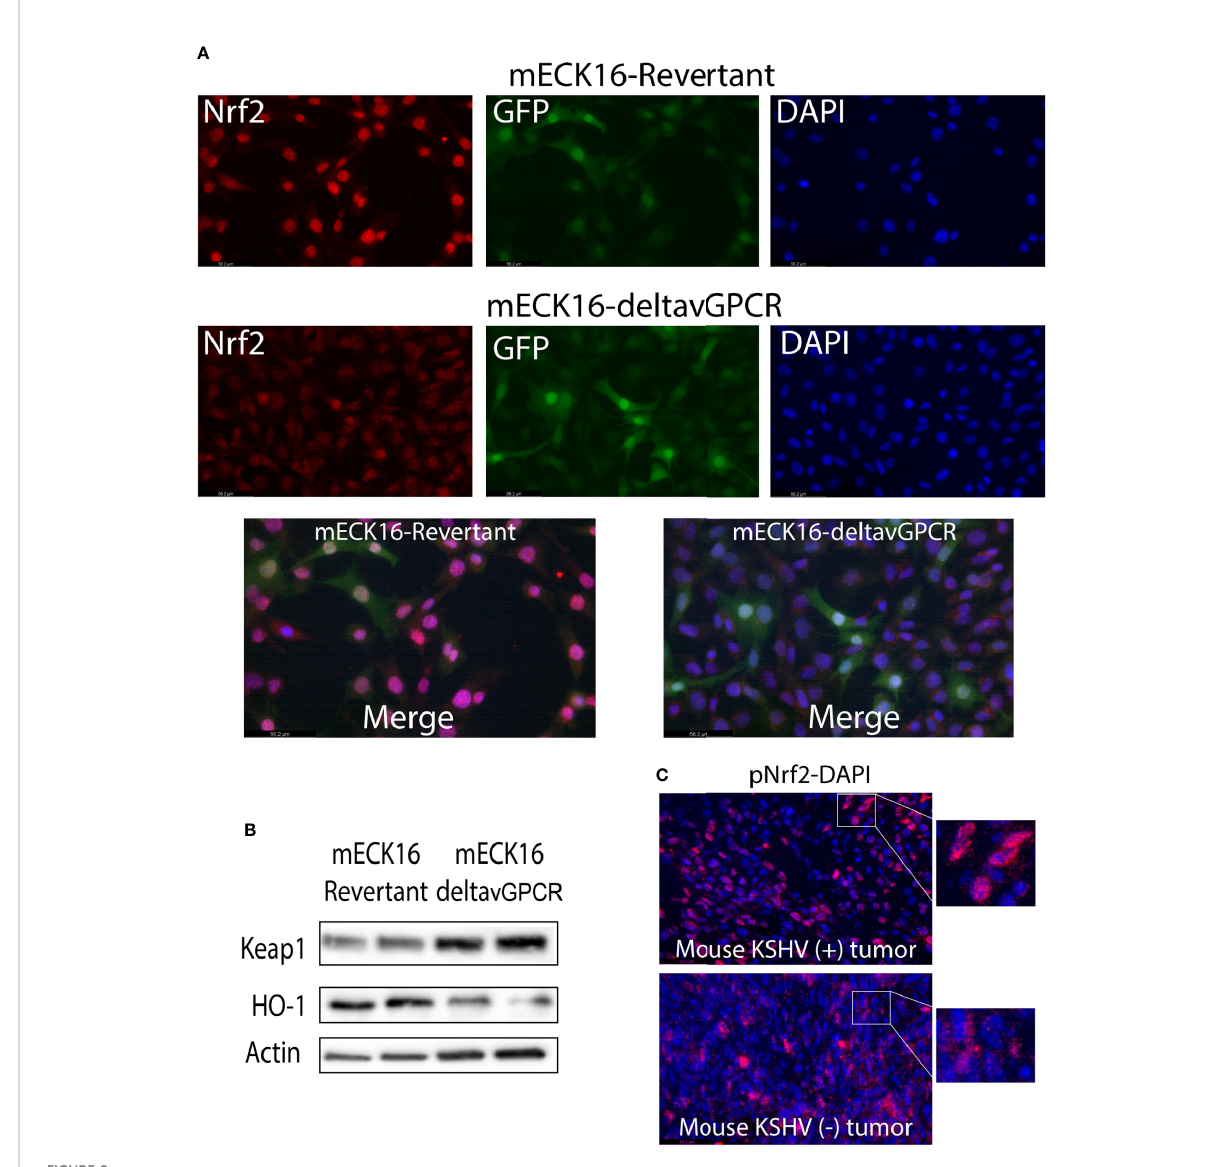
FIGURE 8 (A) Immuno fl uorescence analysis of mECK16-revertant and mECK16- D vGPCR cells to evaluate Nrf2 expression (red), GFP signal comes from the BAC16 plasmid (green), and nuclei were counterstained with DAPI (blue). (B) Western Blot Assays were performed in mECK16-revertant and mECK16- D vGPCR cell lines for the expression of Keap1 and HO-1; Actin was used as a loading control. (C) Immuno fl uorescence analysis of mouse KSHV (+) and mouse KSHV ( – ) tumors to evaluate Nrf2 phosphorylation (red), nuclei were counterstained with DAPI